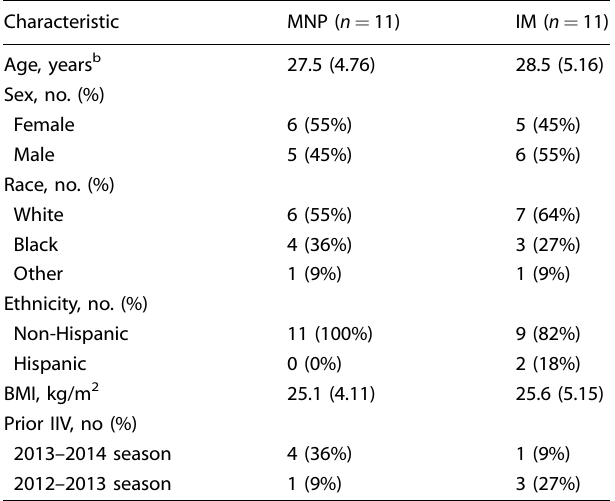
a No statistical differences, assessed using Student ’ s t test for continuous variables and chi-square tests for categorical variables, were observed between the groups for any variable. b Continuous variables are presented as mean